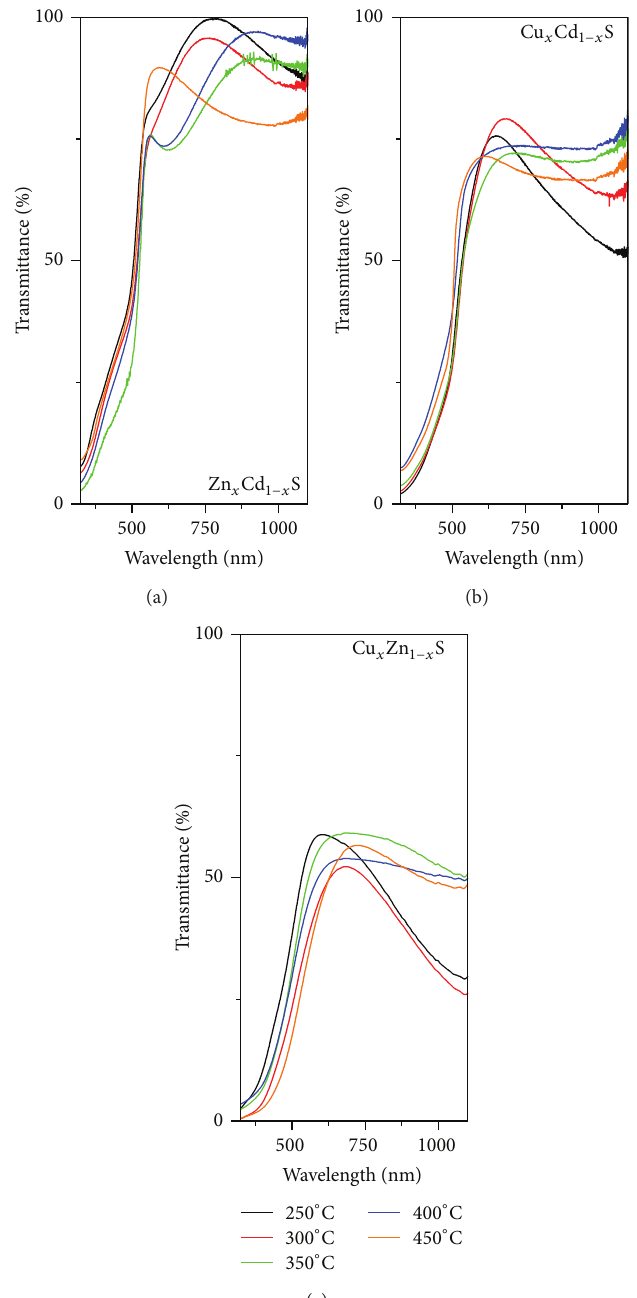
Figure 3: Optical transmittance spectra of the ternary semiconductor compounds studied.